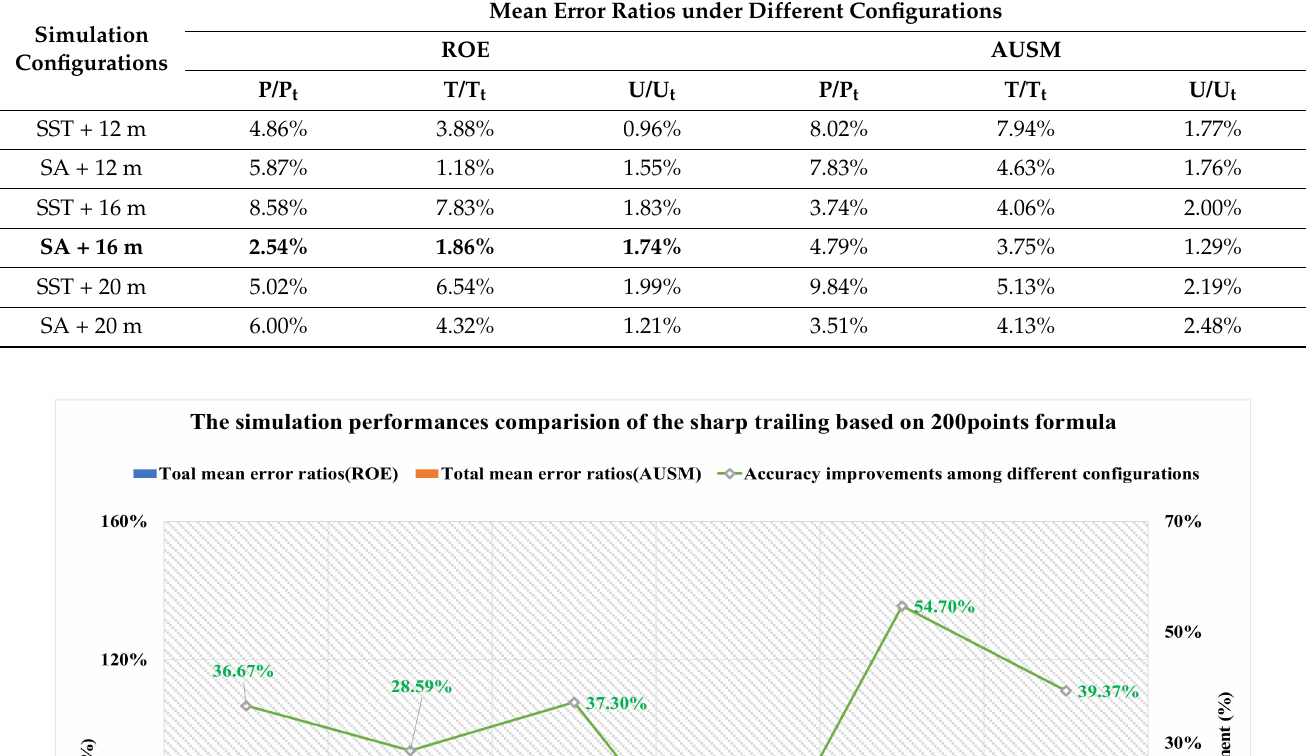
Table 16. The mean error ratios of P/P t , T/T t , and U/U t of the sharp trailing edge based on 200 points.